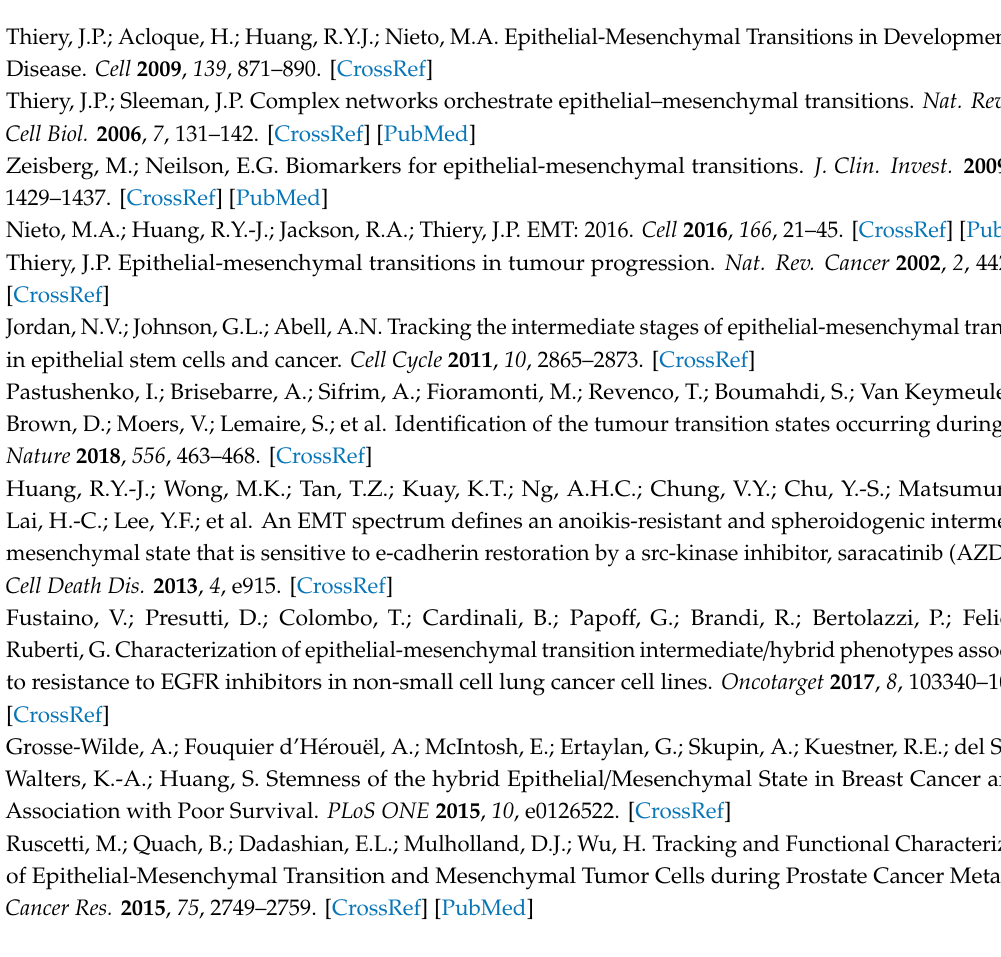
Supplementary Materials: The following are available online at http: // www.mdpi.com / 2072-6694 / 12 / 5 / 1140 / s1: Figure S1: SNAI1 overexpressing cells in ovarian cancer cells induce di ff erential functional changes. Figure S2: Chromatin states at PERP and ERBB3 amplicon regions in a four-cell-line EMT spectrum model. Figure S3: Full-length blots. Table S1: List of primers used for ChIP analysis. Table S2: List of primers used for qPCR analysis. All primers except RAD21 were purchased from Qiagen. Table S3: List of antibodies used in this